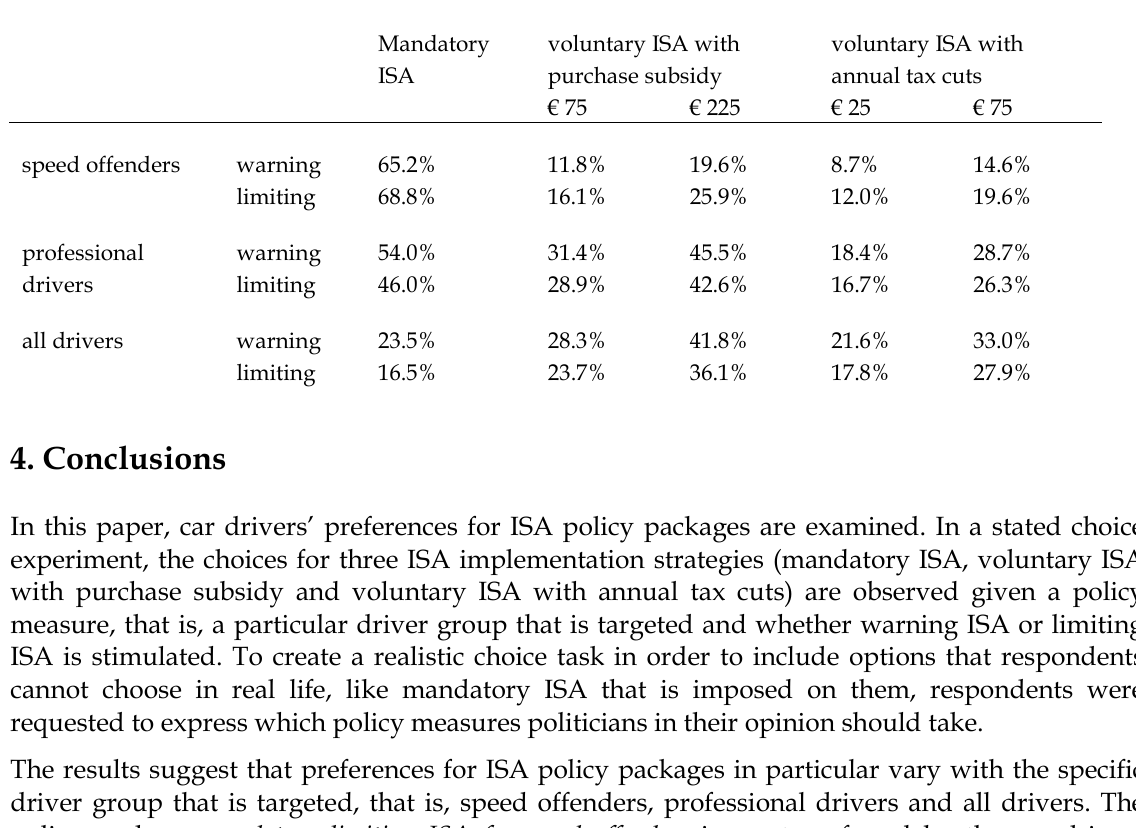
Table 4. Predicted preference shares for various policy